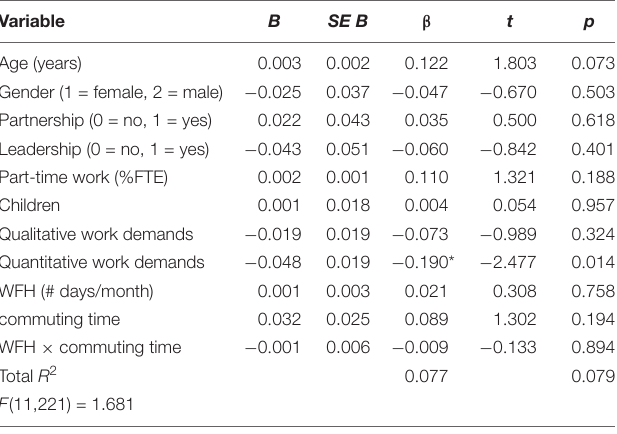
TABLE 6 | Multiple linear regression analysis for the interaction between work from home (WFH) and commuting time in predicting improved work-life balance during COVID-19 pandemic (H5).